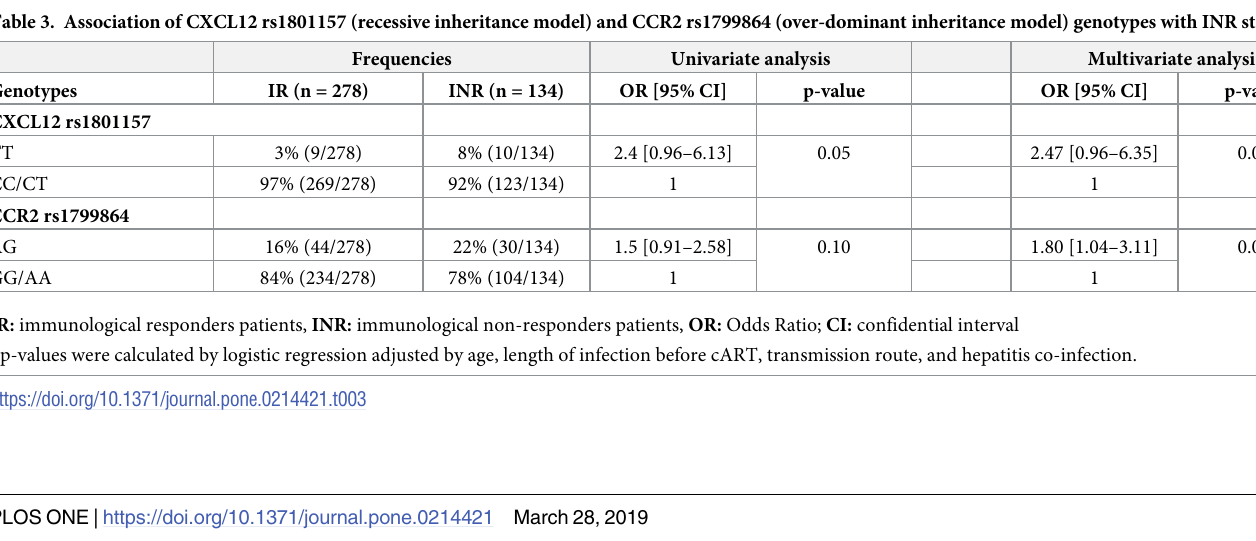
CXCL12 rs1801157 TT genotypes were associated with a higher probability of having poor CD4 T-cell recovery in HIV patients despite complete viral suppression with cART. No